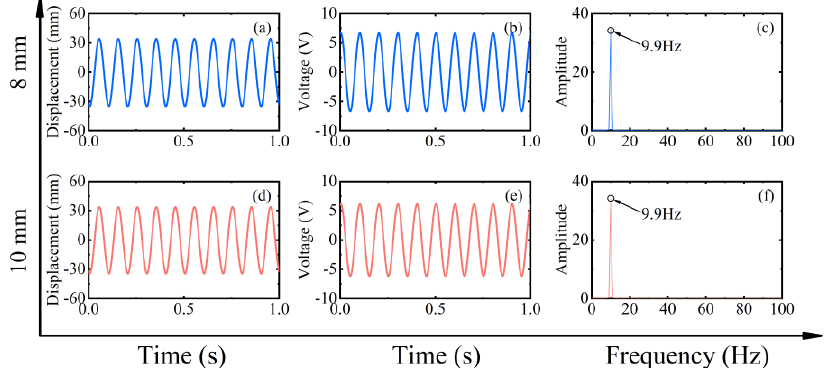
Figure 13. Simulation results of magnet spacing of 8 mm (blue line) and 10 mm (red line) at 90 rpm (4.5 Hz) in frequency up-conversion mechanism, ( a , d ) are the corresponding measured displacements, ( b , e ) are the corresponding measured output voltages, and ( c , f ) are the corresponding power spectrums.